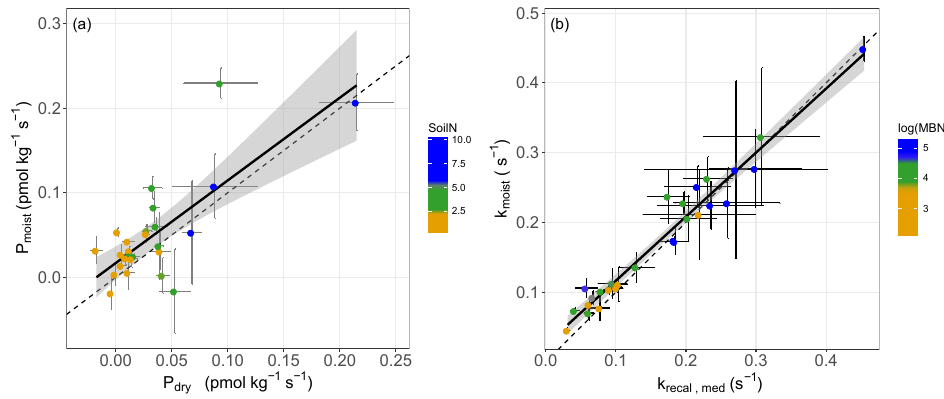
Figure 2. (a) Comparison of the soil COS production rates measured on air-dried soils ( P dry ; Method 1) and moist soils ( P moist ; Method 2) for the range of total soil nitrogen concentrations (gkg − 1 ) measured at each site. (b) Comparison of the COS hydrolysis rate of moist soils ( k recal , med and k moist , respectively) for the range of microbial biomass nitrogen (MBN) (µgg − 1 ) at each site. Each point represents the mean flux ± SD for each site measured at 18 ◦ C ( n = 3). The dashed lines represent the 1 : 1 slope, the solid black lines represent the slope of the linear models and the grey areas represent the 95% confidence level interval for predictions from the linear